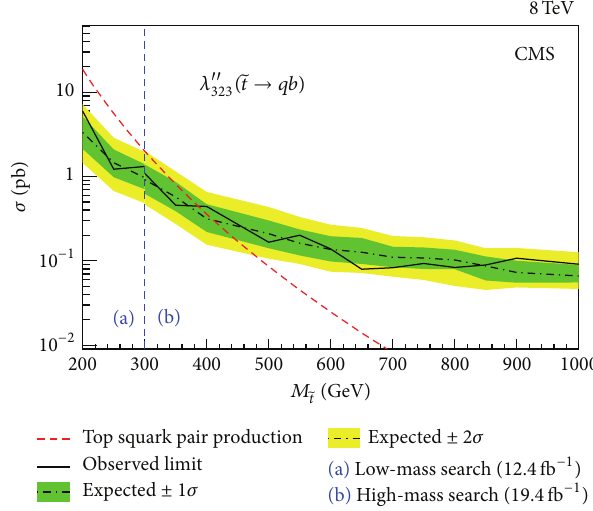
Figure 3: Exclusions on the RPV heavy flavor squark simplified model from the 8 TeV run of the LHC [5]. Color codes are the same as in Figure